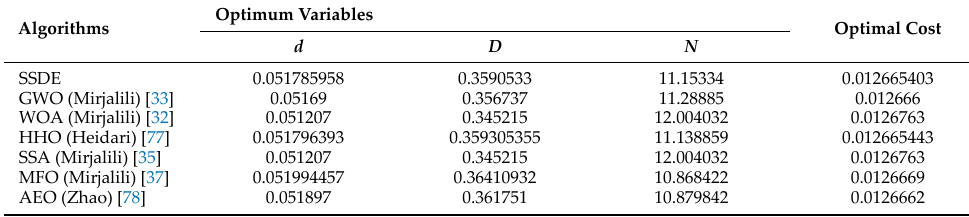
Table 8. Comparison of results of the tension/compression spring problem.